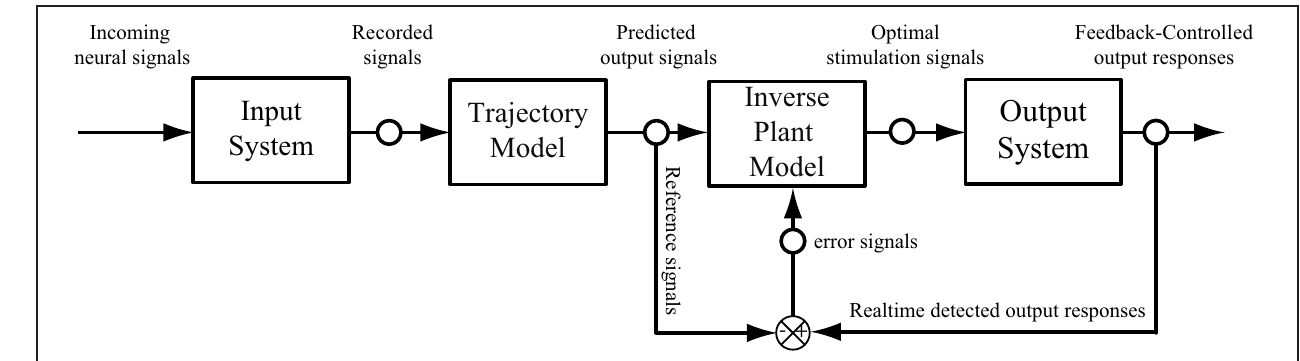
Frontiers in Neural